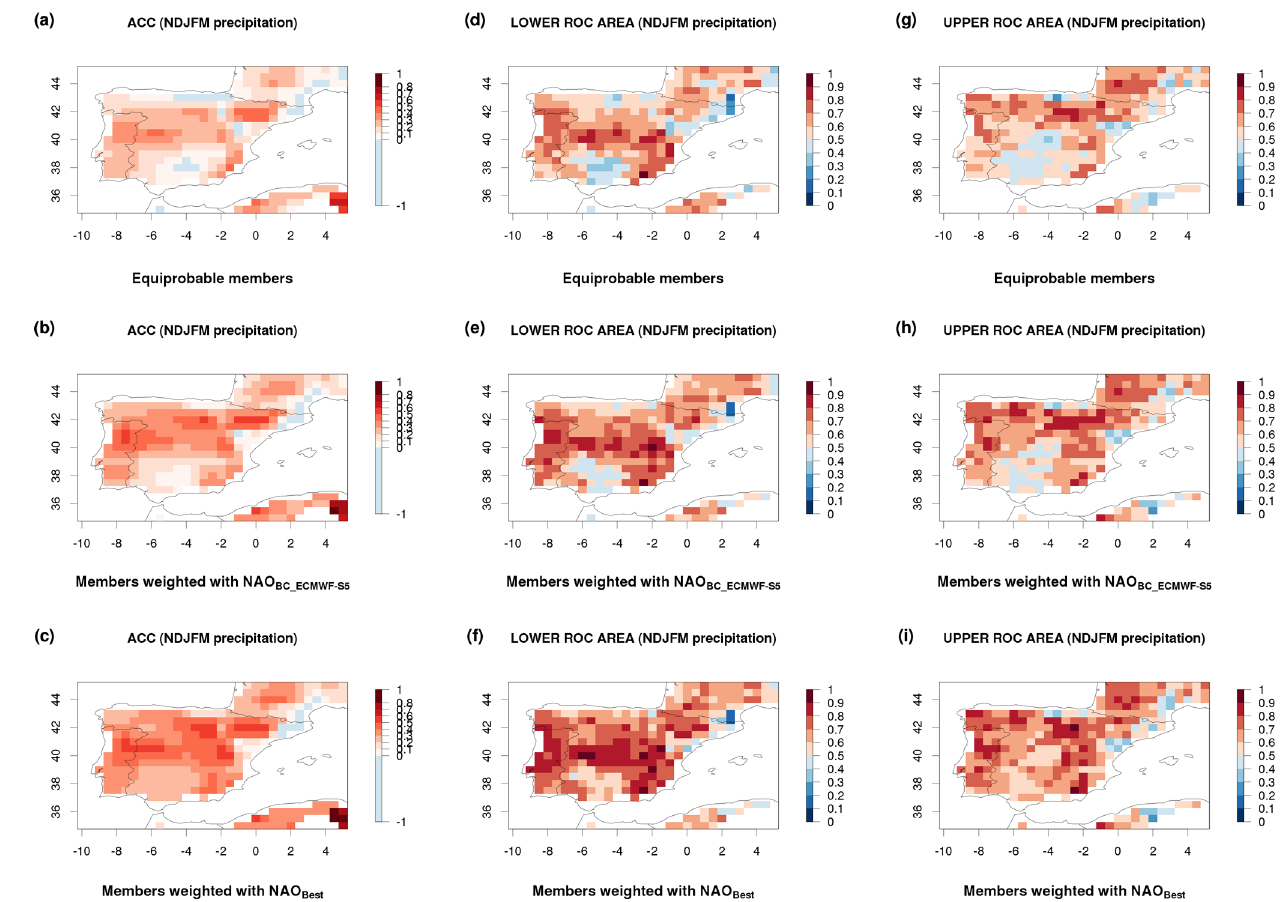
Figure 4. Anomaly correlation coefficient (a, b, c) , lower ROC area (d, e, f) and upper ROC area (g, h, i) for seasonal forecasts of total precipitation (from November to March, initialized with October data) corresponding to ECMWF System 5 with: equally weighted ensemble members (a, d, g) , weighted members with the bias corrected ECMWF System 5 NAO Gaussian pdf NAOBC_ECMWF-S5 (b, e, h) and weighted members using the Best NAO Gaussian pdf estimate NAOBest (c, f, i) . Seasonal forecasts are verified against the gridded E-OBS observational database. The hindcast period covers 1997–2016. The number of ECMWF System 5 ensemble members for the hindcast period is